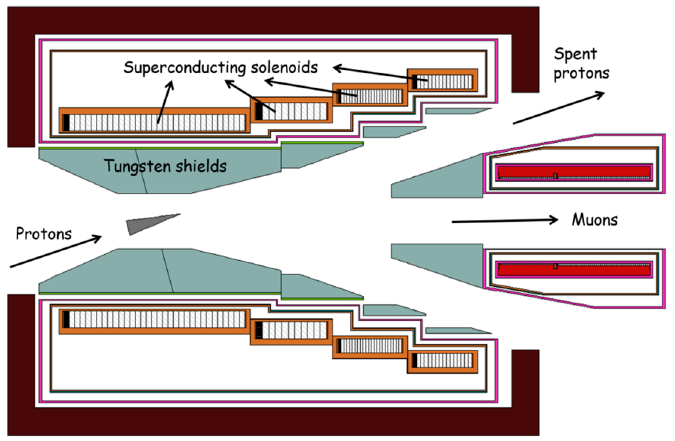
Figure 3. Schematic for the Experimental Muon Source (EMuS) target station.